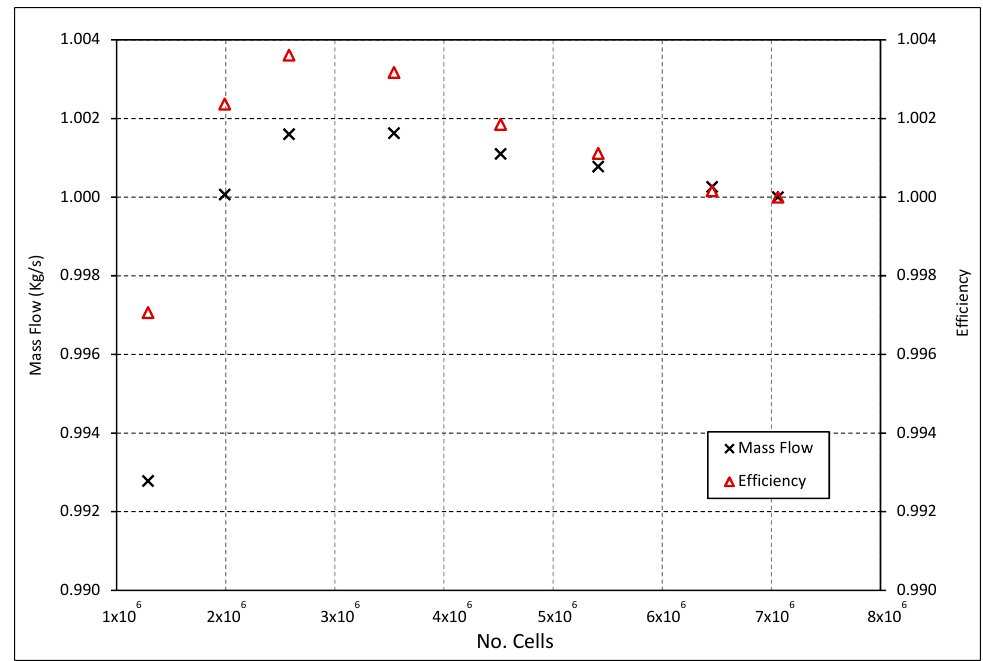
Figure 5. Rotor mesh study.